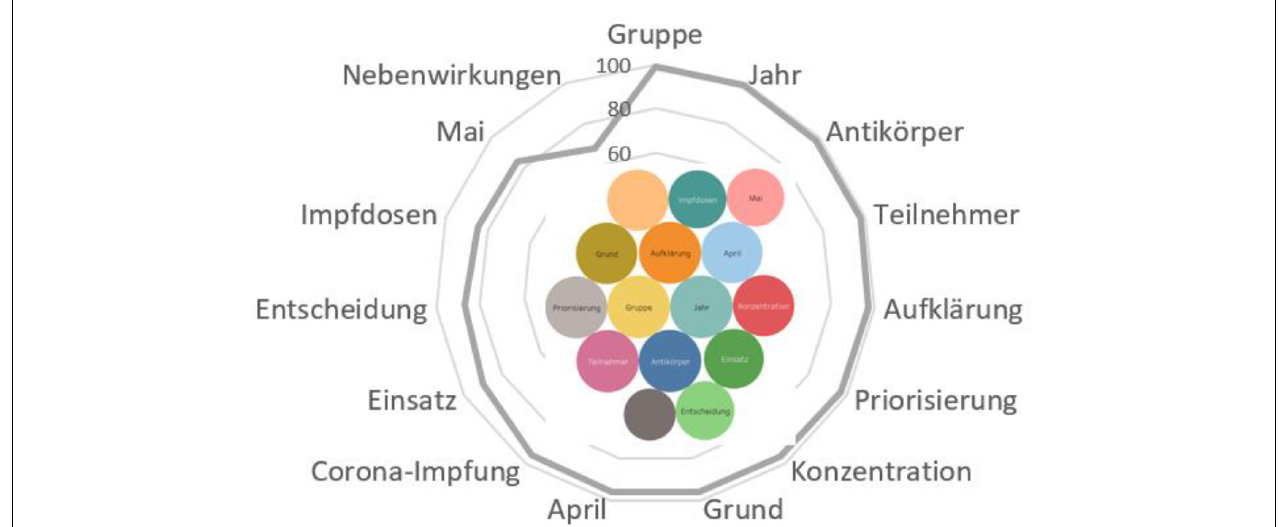
FIGURE 6 | Associative network of the stimulus risk group